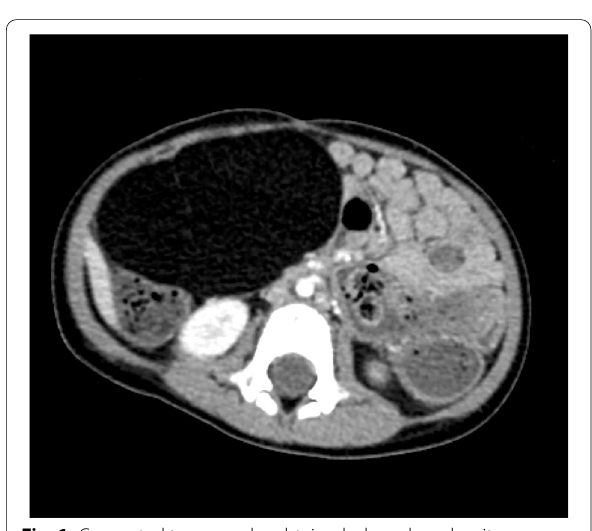
Fig. 1 Computed tomography obtained a large low-density mass within the mesentery, measuring approximately 8